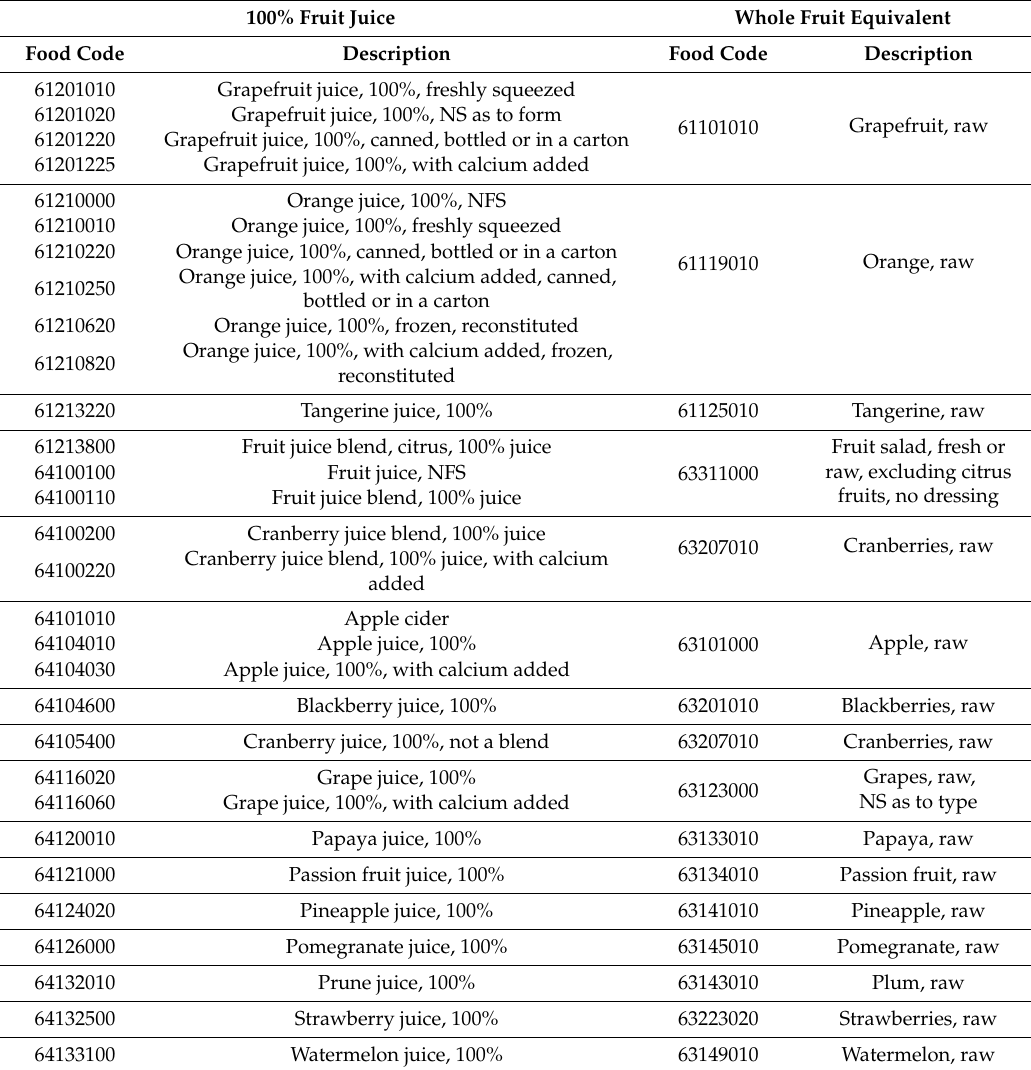
Table 1. Food codes of 100% fruit juices and of whole fruit equivalents used for 100% fruit juice